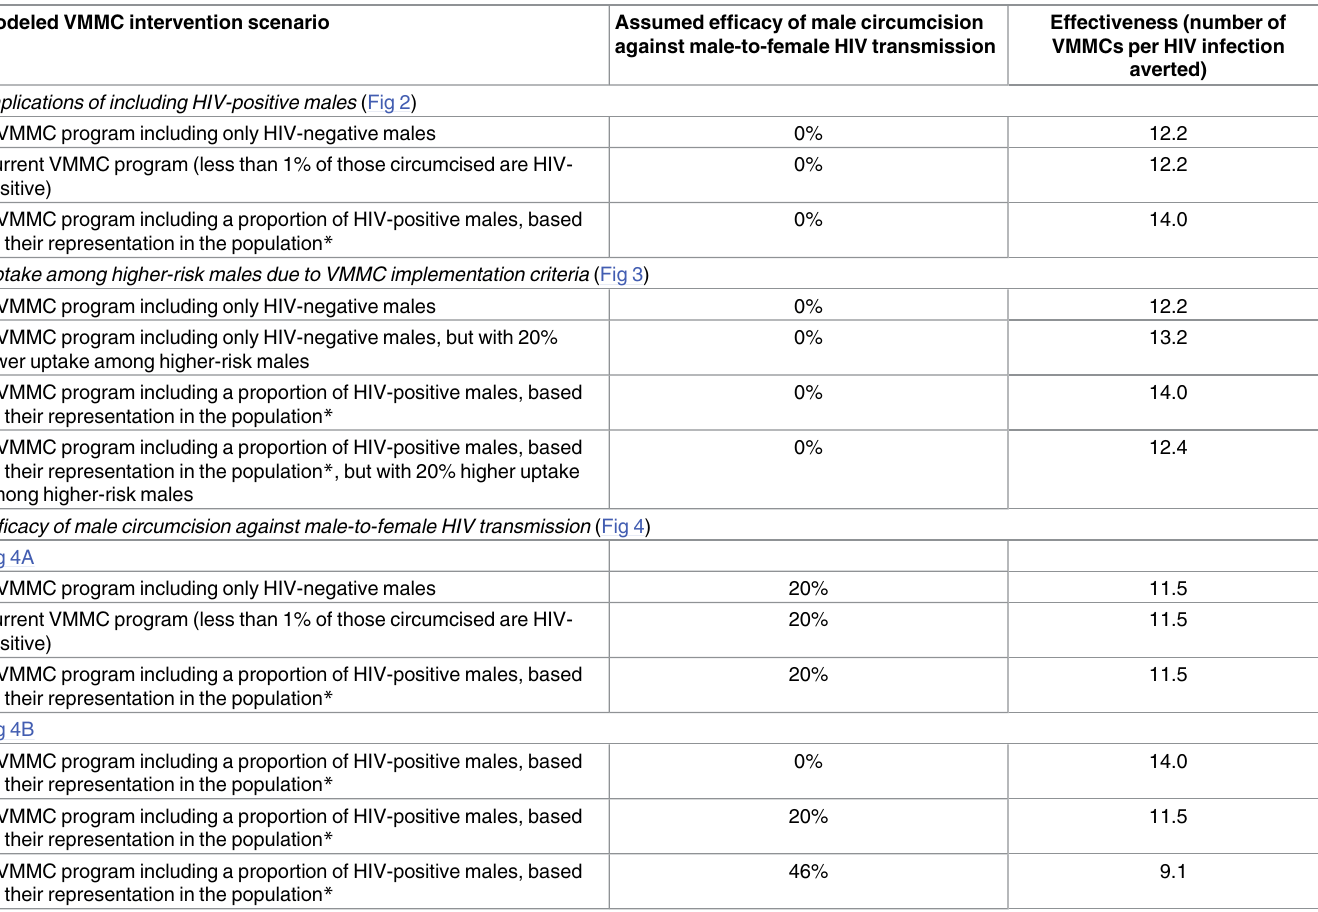
Table 1. Effectiveness of the VMMC program in Zambia under different VMMC intervention